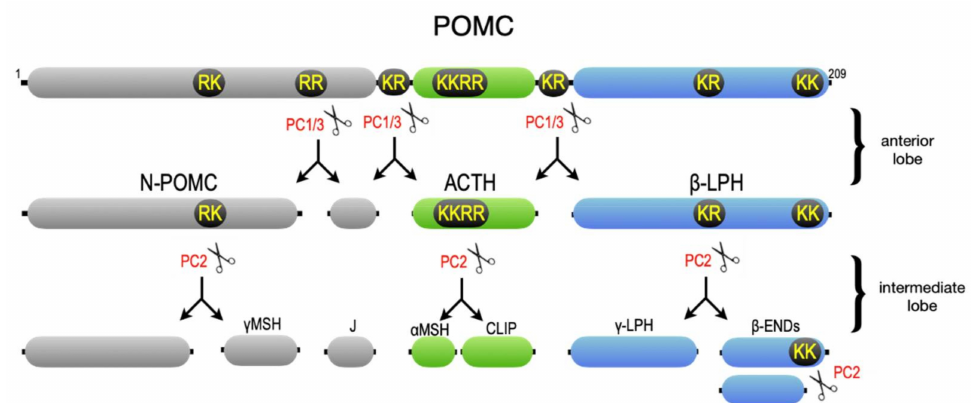
Figure 2. POMC. Shown are the processing steps that occur in the pituitary anterior lobe and neurointermediate lobe. The sites cut by proprotein convertases PC1/3 and PC2 are shown. For a recent review, see